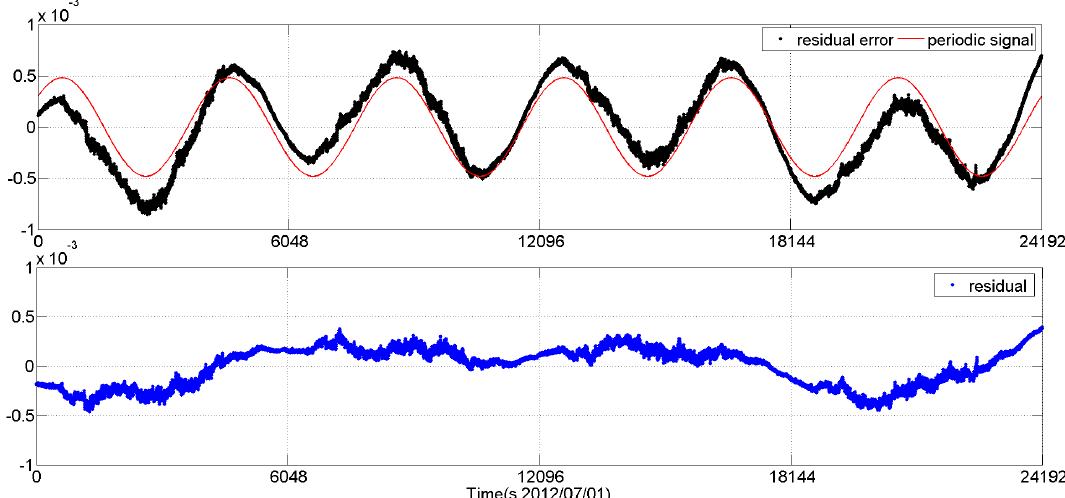
Figure 2. The second pass periodic signal extraction results of q 0 element of CCD01 quaternion data (a sinusoidal signal with a period of 4032 s is extracted).